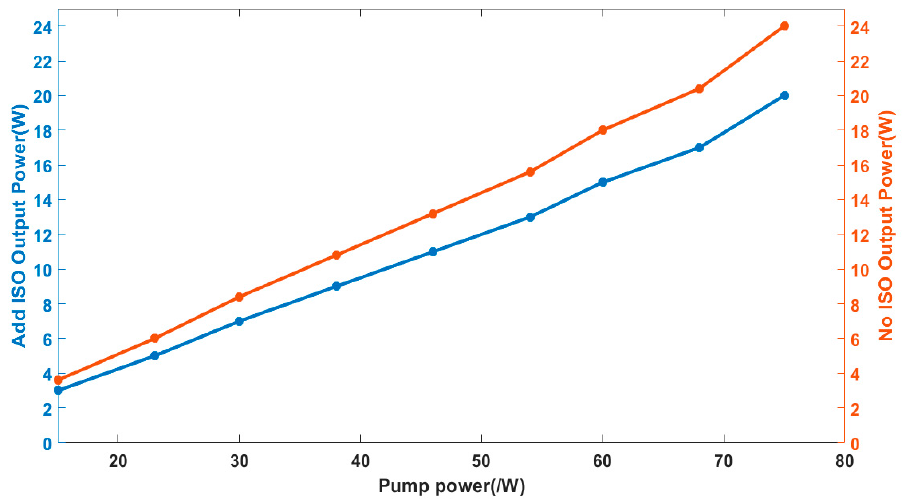
Figure 5. Output power of the last pump amplifier versus pump power.